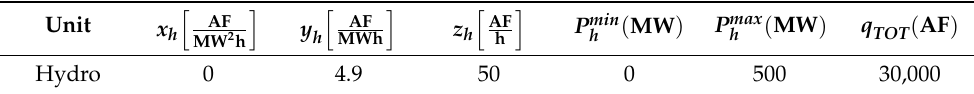
Figure 6. Hydrothermal scheduled power, bus price, and line limit price. Due to combined investigations of economic hydrothermal scheduling and DCOPF at the same time, the system lambdas ( λ ) represent the bus location marginal price (LMP) or nodal price and line congestion price instead of the generator’s incremental cost. Figure 6 shows both lambdas ( λ ) under two di ff erent scenarios.